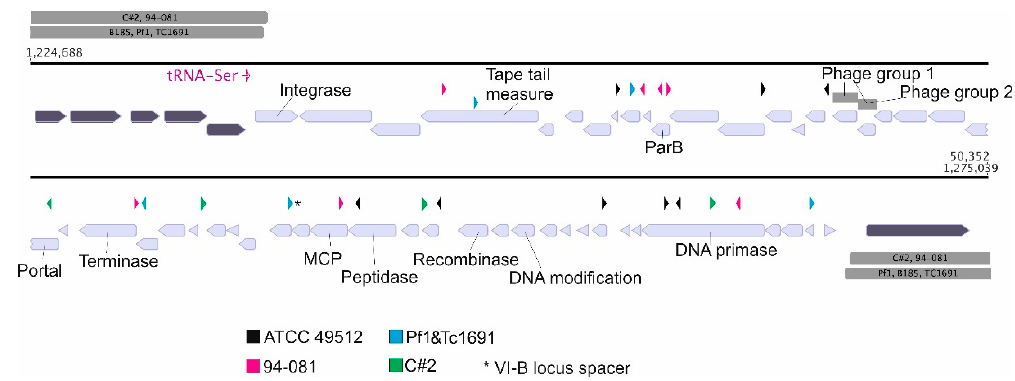
Figure 4. A putative prophage region pp49512 in the F. columnare strain ATCC 49512 with unique Clustered Regularly Interspaced Short Palindromic Repeats (CRISPR) spacers in different F. columnare strains that target the sequence in pp49512 (light colored ORFs) in the strain ATCC 49512 (ORFs surrounding the prophage are marked with darker color). All spacer hits from complete genome sequences with a maximum of two mismatches are shown with a color corresponding to the strain name indicated at the bottom (see also Supplementary Table S7). The direction of spacers was applied from [22]. Open reading frames (ORFs) with putative functions in the prophage are marked. The matching nucleotide sequences from other F. columnare genomes on both sides of the putative prophage area are shown in gray. Both sides have ~100% identity with strains TC1691, Pf1, B185, C#2, and 94-081. Sequences (~20 kbp area) that correspond to Finnish F. columnare phage isolates are also indicated (Phage group one: FCL-2, FCV-1, FCV-3, FCV-10, FCV-11, FCV-16, FCV-20, VK42, VK48. VK58; Phage group 2: V156, V157, V165, V181, V182). MCP stands for major capsid protein. See Supplementary Table S6 for details of the pp49512 ORFs.